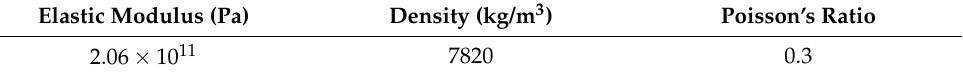
Table 1. Material properties for steel plate.